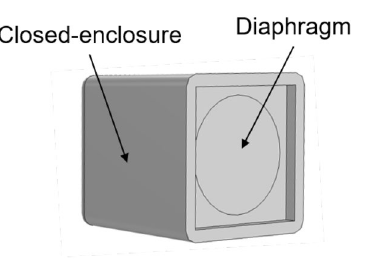
Figure 4. The speaker model used in the simulation is a closed-enclosure structure, and the sound is generated by oscillating the diaphragm.